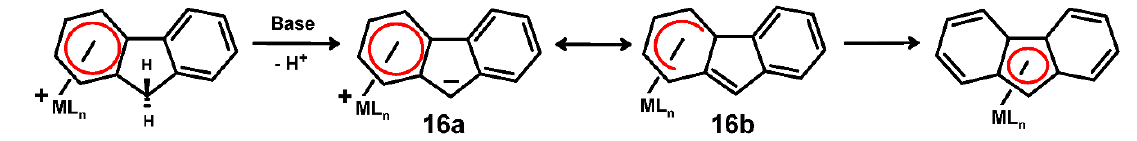
Figure 3. X-ray crystal structures of ( left ) ( η 6 -cppH)Cr(CO) 3 and ( right ) ( η 5 -cpp)Mn(CO) 3 .